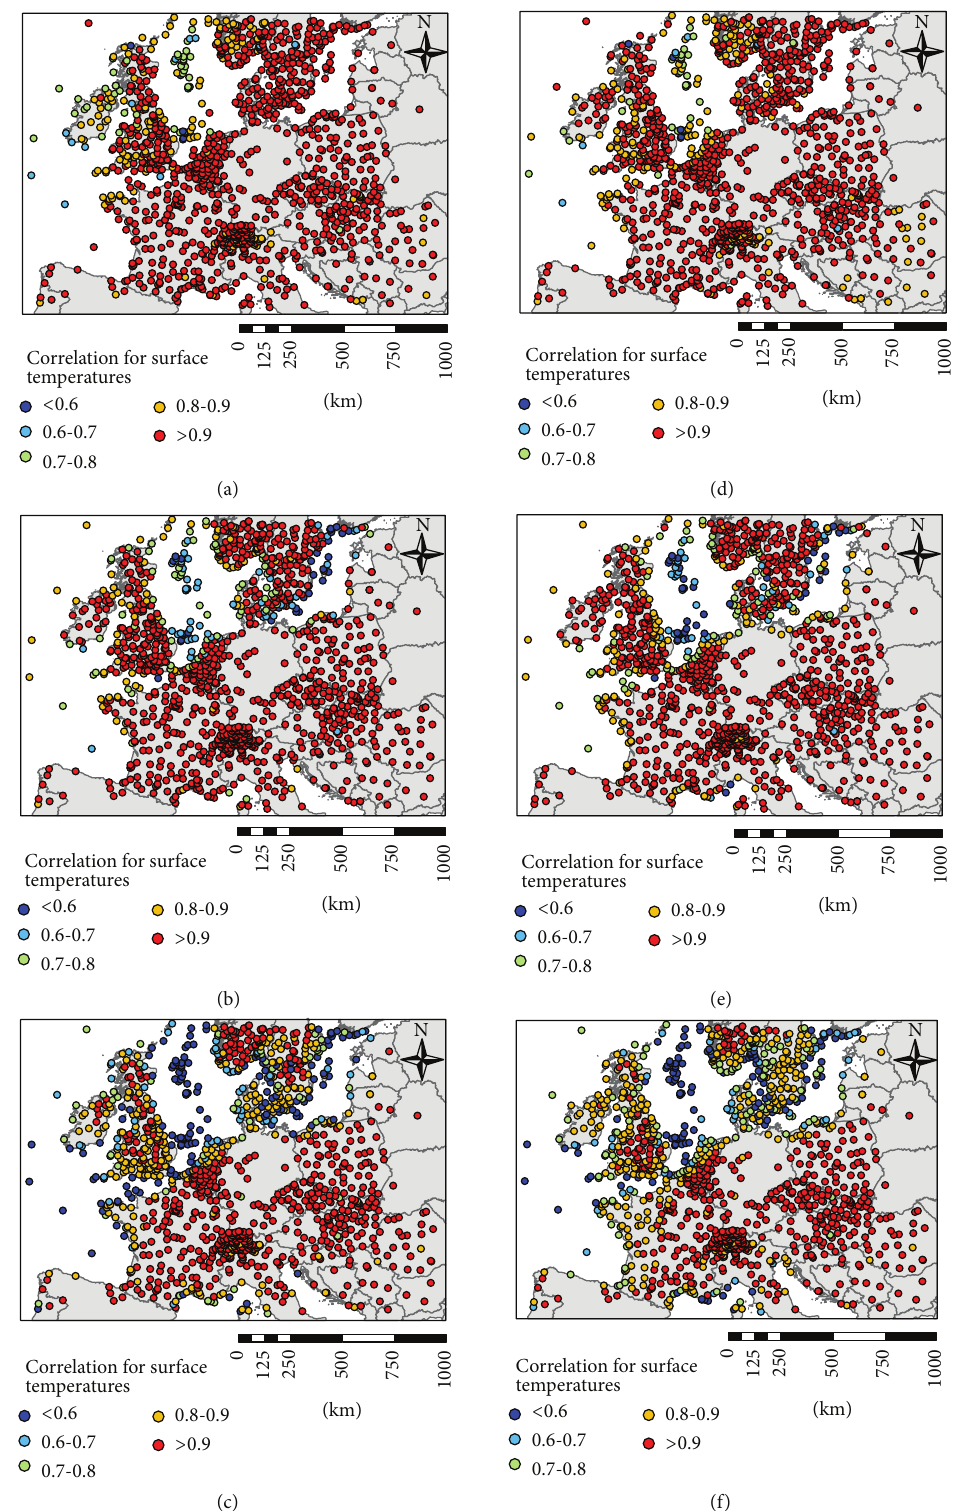
Figure 3: Correlation between simulation and observed daily mean temperatures for Q1 ((a) and (d)), Q2 ((b) and (e)), and Q3 ((c) and (f)) at 1182 sites in central-northern Europe. First column corresponds to WRF-Chem simulations with 36 km resolution and second column to WRF-Chem simulations with 12 km